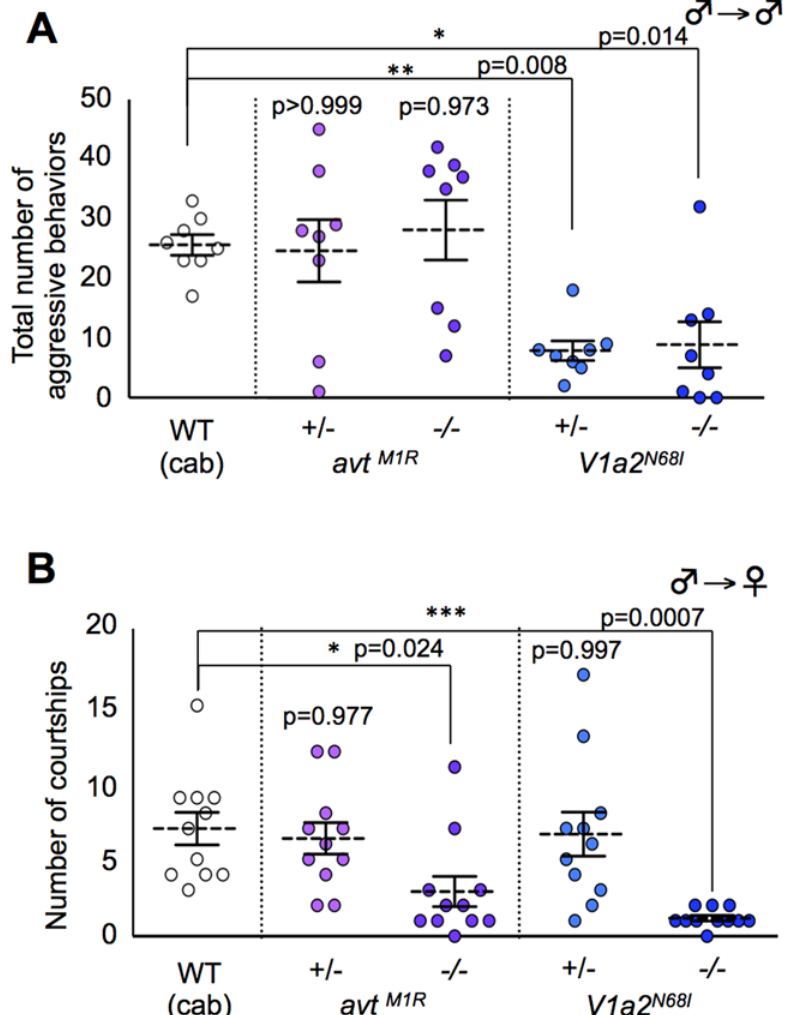
Fig 4. Effect of AVT-related genes mutations on aggressive behavior (intrasexual interaction) and courtship behavior (intersexual interaction). (A) avt mutant males exhibited normal aggression, whereas V1a2 heterozygote and homozygote mutant males exhibited low aggression. Mean ± SEM. Each n = 8, Dunnett ’ s test: * P < 0.05, ** P < 0.01 VS wild-type. (B) avt and V1a2 mutant males showed lower motivation to mate than wild-type males. Mean ± SEM. Each n = 11, Dunnett ’ s test: * P < 0.05, *** P < 0.001 VS